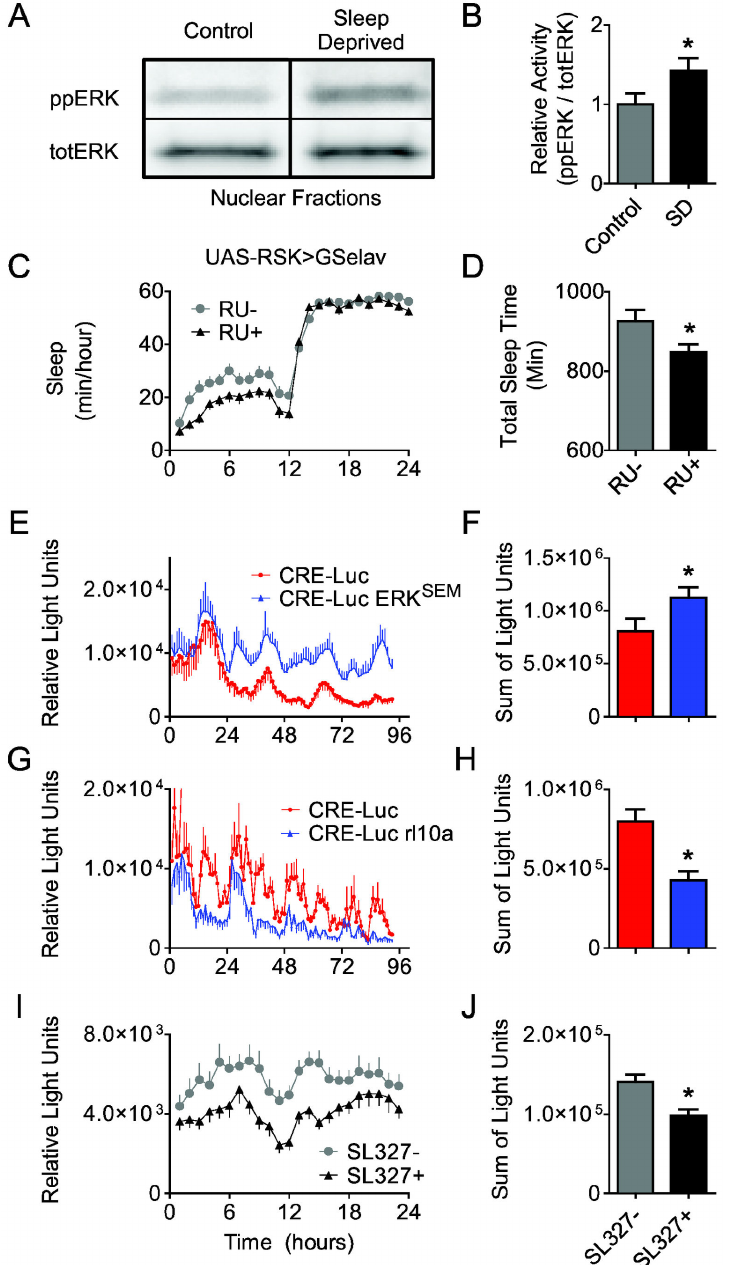
Figure 6. ERK affects CRE-luciferase reporter activity. A , Western blot showing an increase in the nuclear localization of ppERK activation following 12 h of sleep deprivation in 5 day old Cs flies (40 heads/lane). B , Quantification of the Western blot in A revealed a statistically significant increase in ppERK/TotERK levels, students t-test, p = 0.032, n=8. Data are presented as mean ± SEM. C , Sleep profile of flies expressing a wild type version of UAS-RSK wt displayed a decrease in sleep. D , Total sleep is significantly decreased in RSK over expressing flies. p = 0.0261; student’s t-test, n= 31-32/group. E , elav/Y; CRE-Luc/UAS-ERK SEM flies (blue trace) have elevated total reporter activity compared to elav/Y; CRE-Luc/+ controls (red trace); n=19-21/group. F , Sum of luciferase activity shown in E ; students t-test, p =0.04). G , Flies that are heterozygous for the MAPK gene rolled ( CRE-Luc/Y; rl 10A /+ ; blue trace) show significant reductions in reporter activity compared to controls ( CRE-Luc/Y; +/CyO ; red trace); n=16-18/group. H , Sum of luciferase activity shown in G ; students t-test, p = 0.0006). I , SL327-fed elav/Y; CRE-Luc/+ (black trace) show significant reduction in reporter activity compared to vehicle controls (red trace); n=48/group. J , Sum of luciferase activity shown in I ; students t-test, p = 0.008). doi: 10.1371/journal.pone.0081554.g006 PLOS ONE |